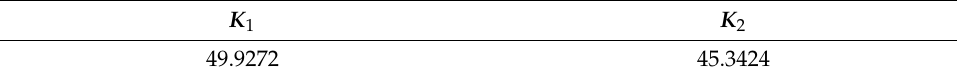
Table 6. DCI controller gains at 80% Table 6 indicates the optimized gains for the DCI, considering a voltage dip of 80%.